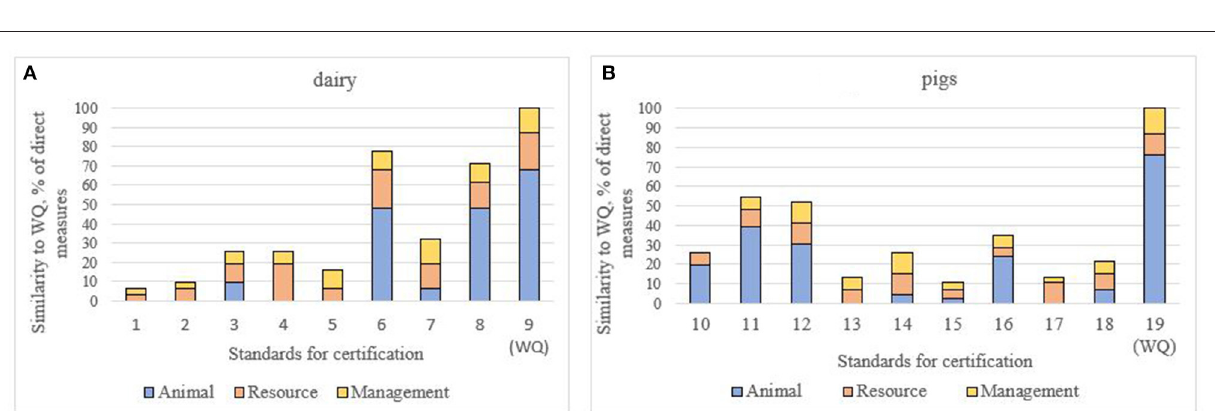
FIGURE 1 | Similarity to WQ ® expressed as direct and indirect correspondence in dairy (A) and pig (B) standards for certification. The direct correspondence was assigned to measures with the same source of information (animal, handling, or environment) as defined in WQ ® . On the contrary, the indirect correspondence was assigned to those measures with different sources of information (e.g., environment instead of animal) as defined in WQ ® . Standards 9 and 19 were based fully on WQ ® . Standards listed in Table 1 were assigned to numbers 1–19.